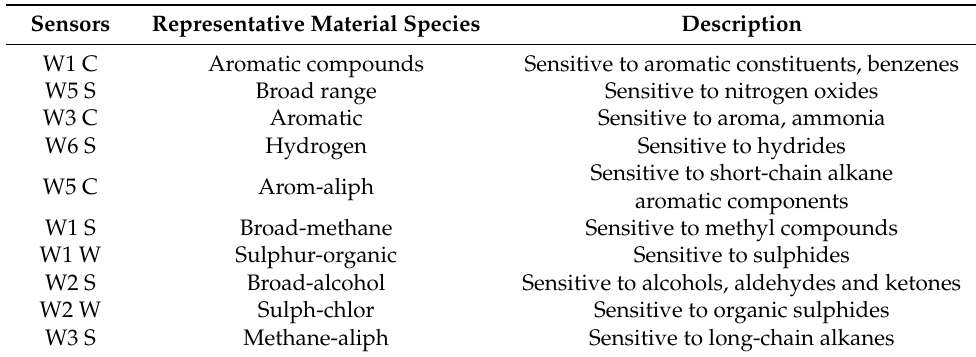
Table 2. Information of 10 sensors for electronic